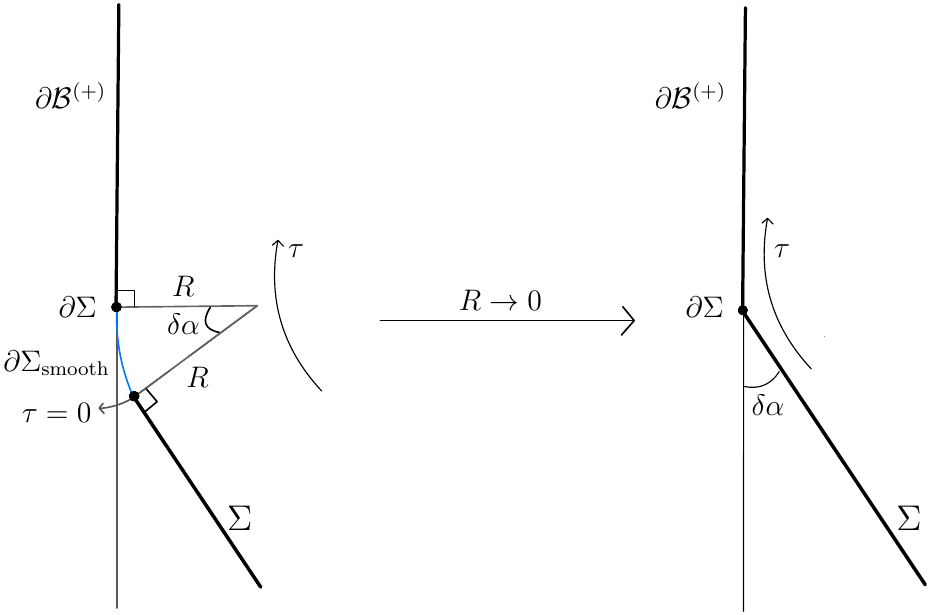
Figure 10 . The T 2 -deformed field theory lives on the Euclidean manifold ∂ B (+) ∪ Σ , as shown on the right. The angle is taken to be infinitesimal at this point of the analysis. Shown is the neighbourhood of the junction. The coordinate τ measures proper distance on both sides of ∂ Σ and takes value τ = 0 at the junction. The left figure shows a smooth geometry with a cap ∂ Σ which is an arc of a circle of radius R . The limit R → 0 , while keeping the angle δα fixed, recovers the final infinitesimal